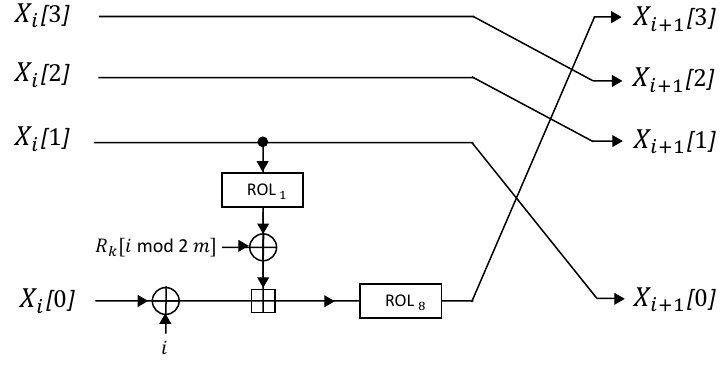
Figure 3. Round function of CHAM.